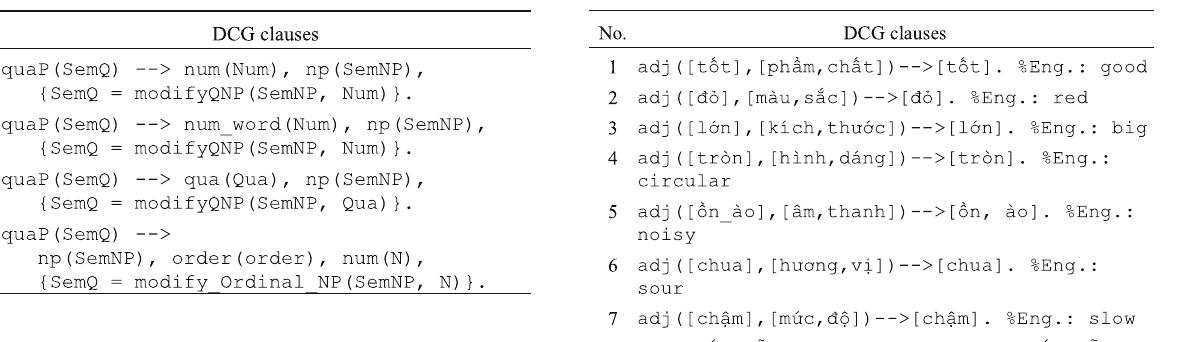
Table 4 DCG clauses process the semantic of quantity phrase Table 5 Semantic form of adjective